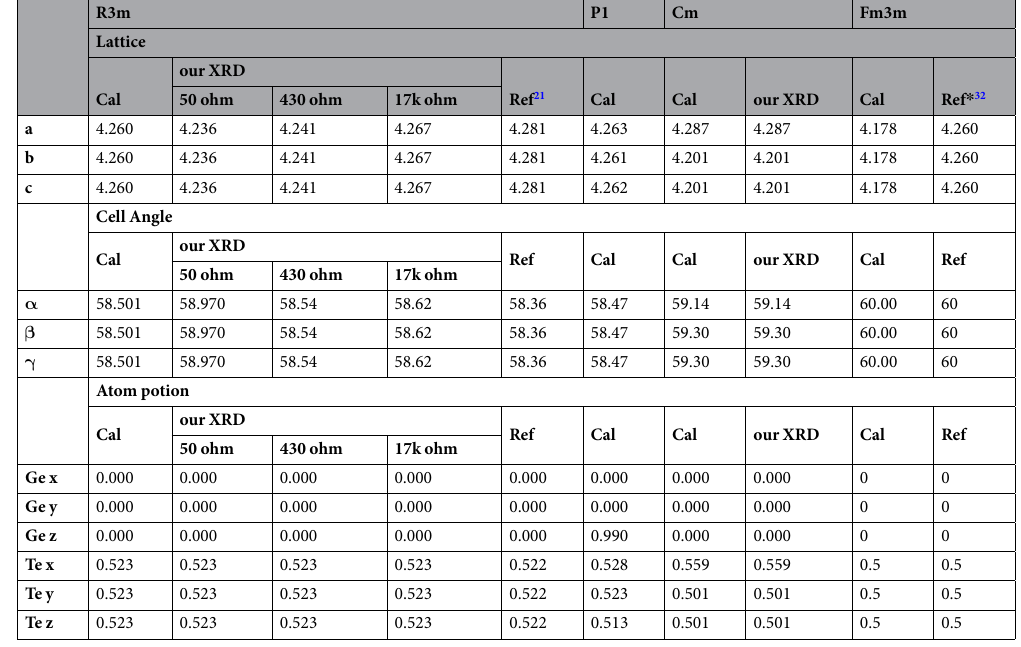
Table 1. Geometric characteristics of GeTe crystal structures. * Measured in 773